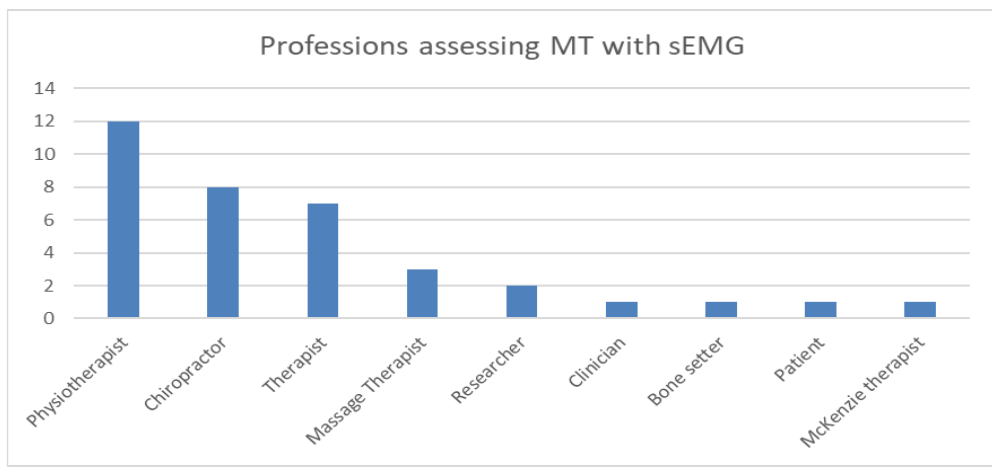
Figure 2. Which professions assessed MT using